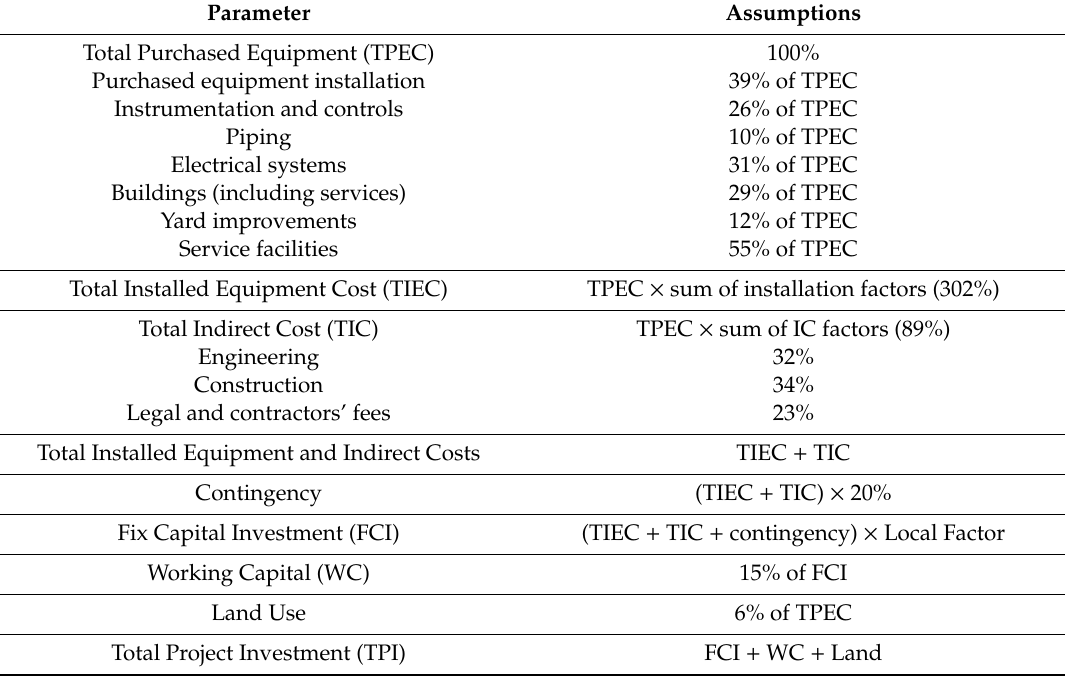
Table 2. Methodology and assumptions used for total capital cost investment